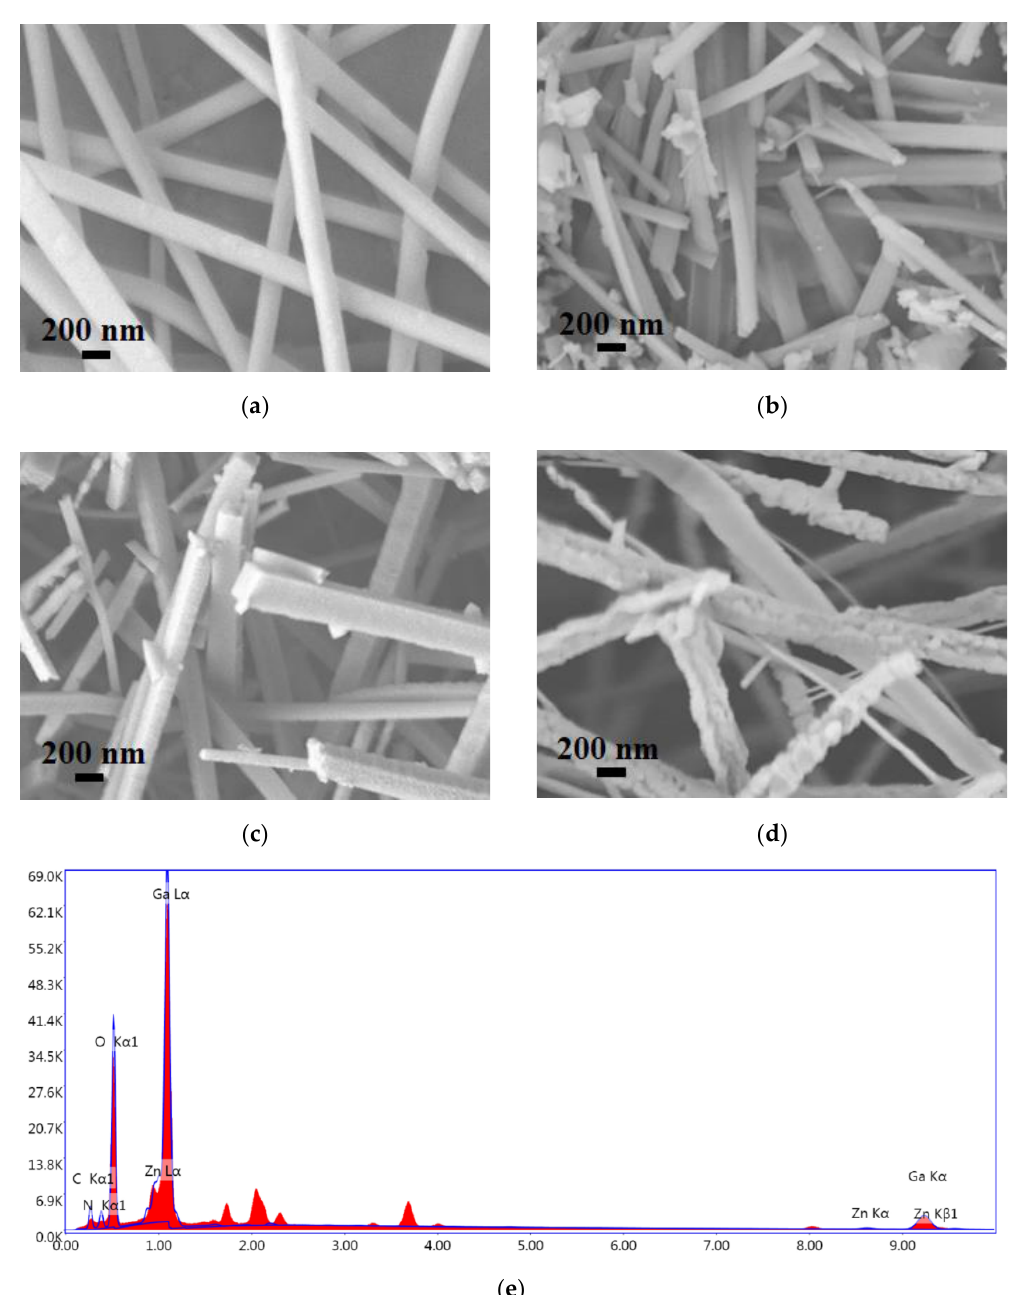
Figure 2. SEM images of ( a ) as-spun nanofibers, ( b ) S 750 , ( c ) S 850 , and ( d ) S 950 and ( e ) the EDS spectrum of S 850.